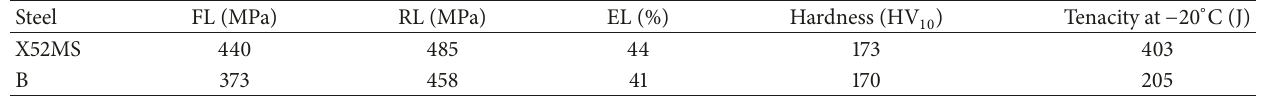
Table 2: Mechanical properties of steels.